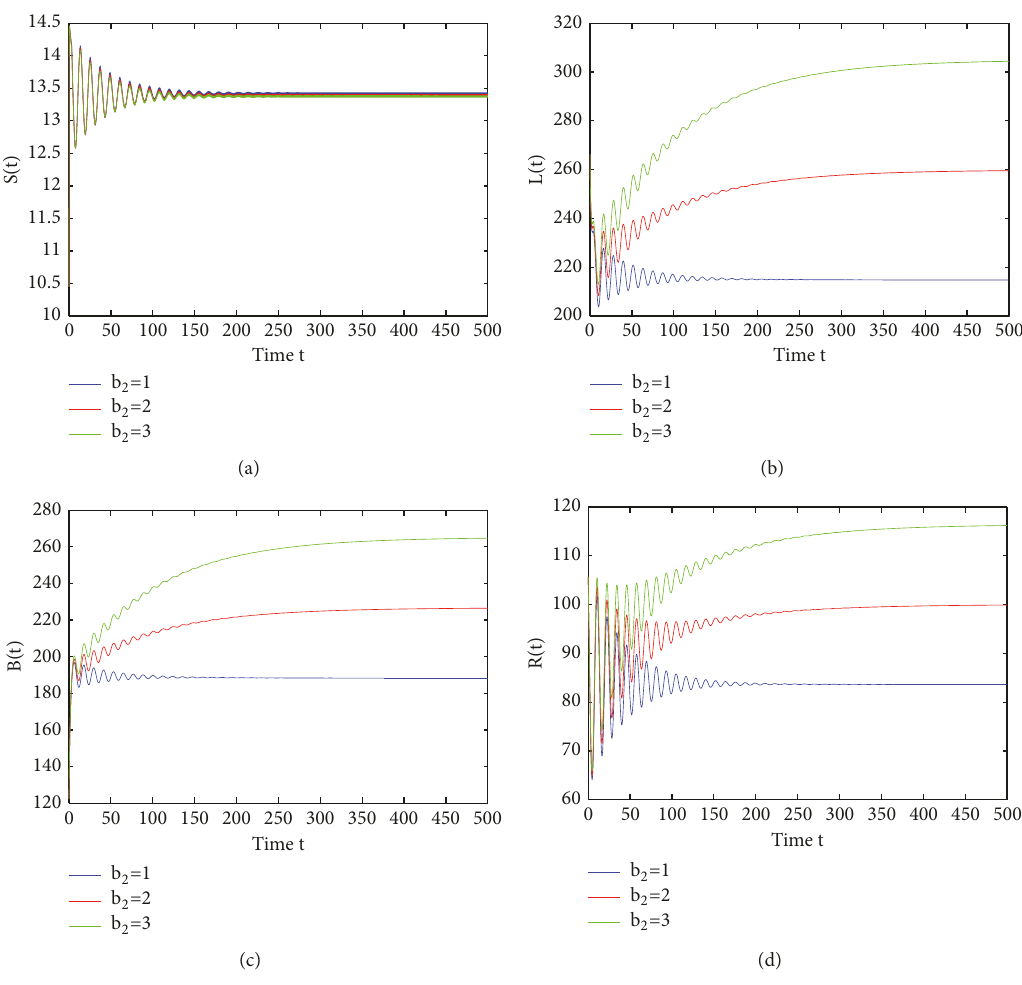
Figure 12: Time plots of 𝑆 , 𝐿 , 𝐵 , and 𝑅 for different 𝑏 2 at 𝜏 = 3.2575 . Rest of the parameters are taken as given in the text.